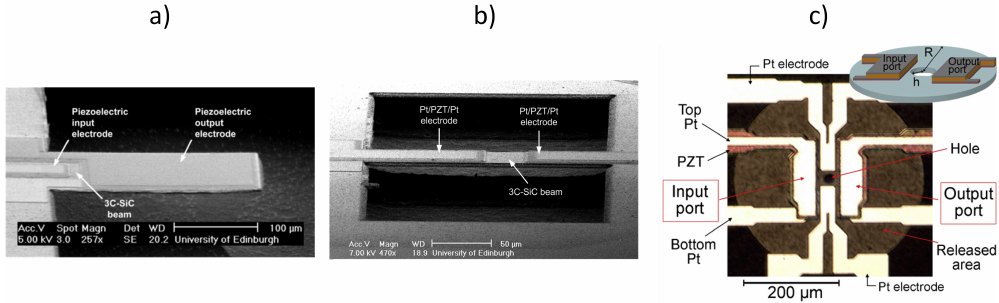
Figure 17. SEM ( a , b ) and optical ( c ) images of 3C-SiC structures with ports for piezoelectric actuation and read out: cantilever [65], bridge [66] and ring [67]. Reprinted with permission from J. Vac.